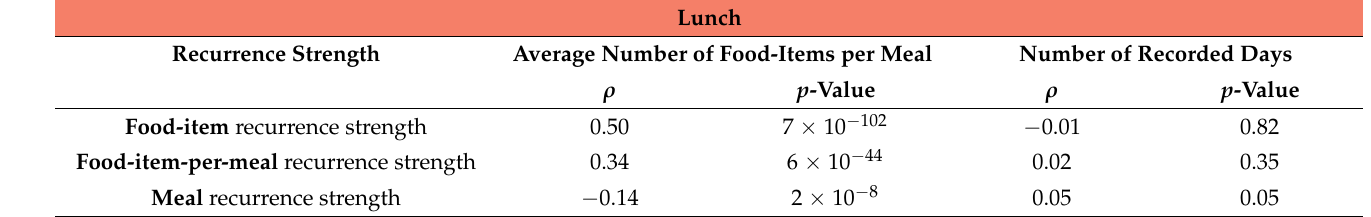
Table 5. Pearson’s correlation coefficient ρ and significance indicated by the p -value between recur- rence strength tuple and other variables for lunch .